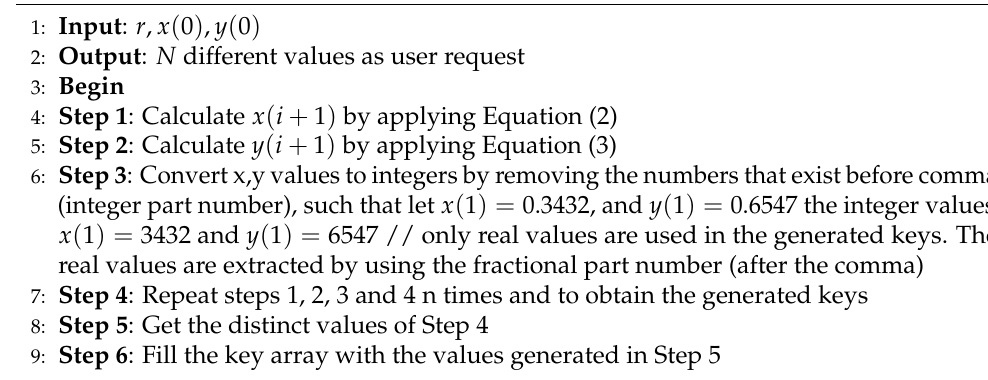
Algorithm 1 Key generation